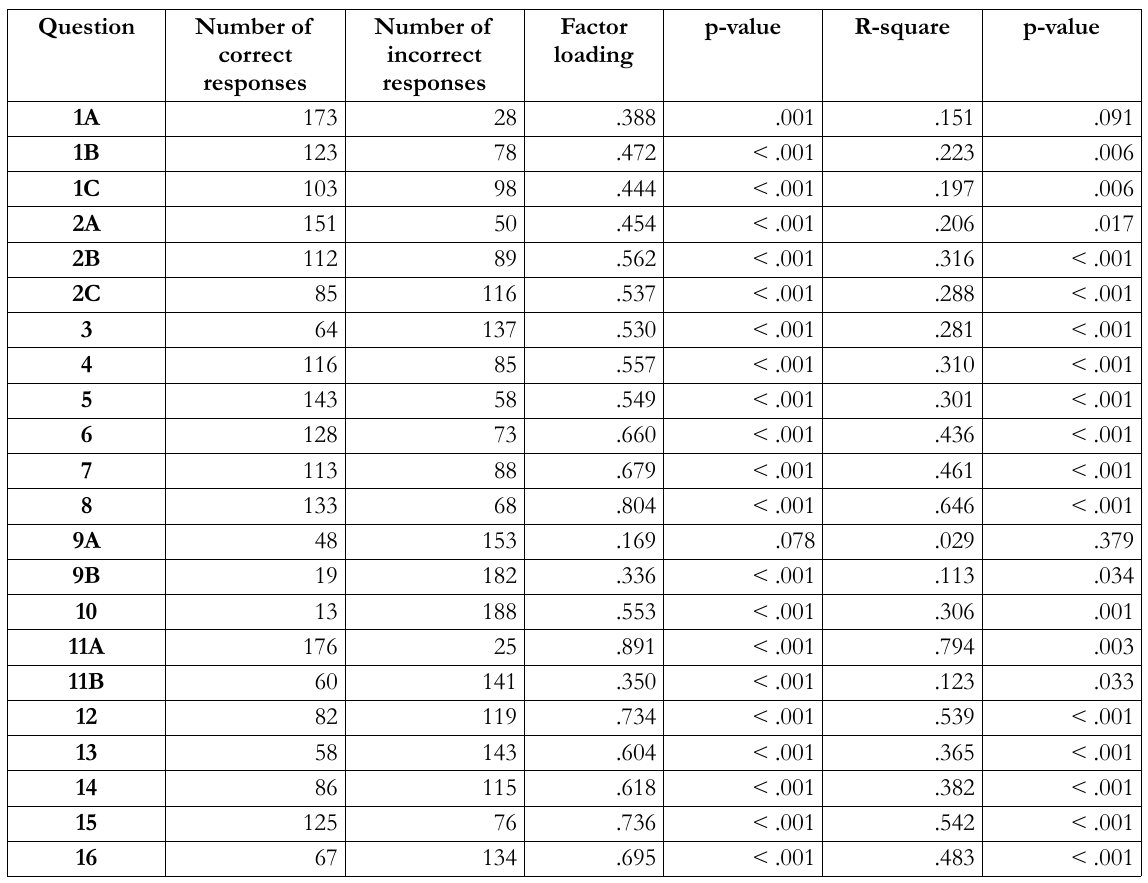
Table 1. Descriptive statistics of the 22-item